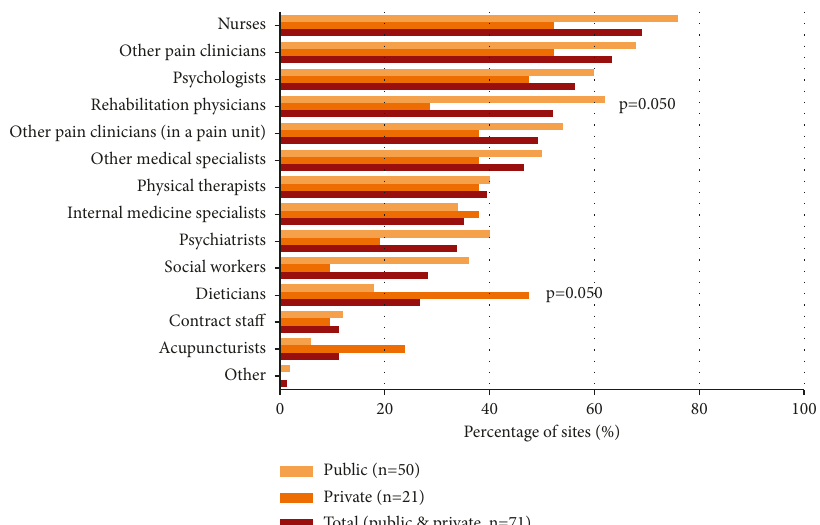
Figure 2: Availability of peer staff at surveyed sites. Multiplicity-adjusted p values (from Chi-square or Fisher’s exact test) are indicated when there is a statistically significant difference between the groups (public and